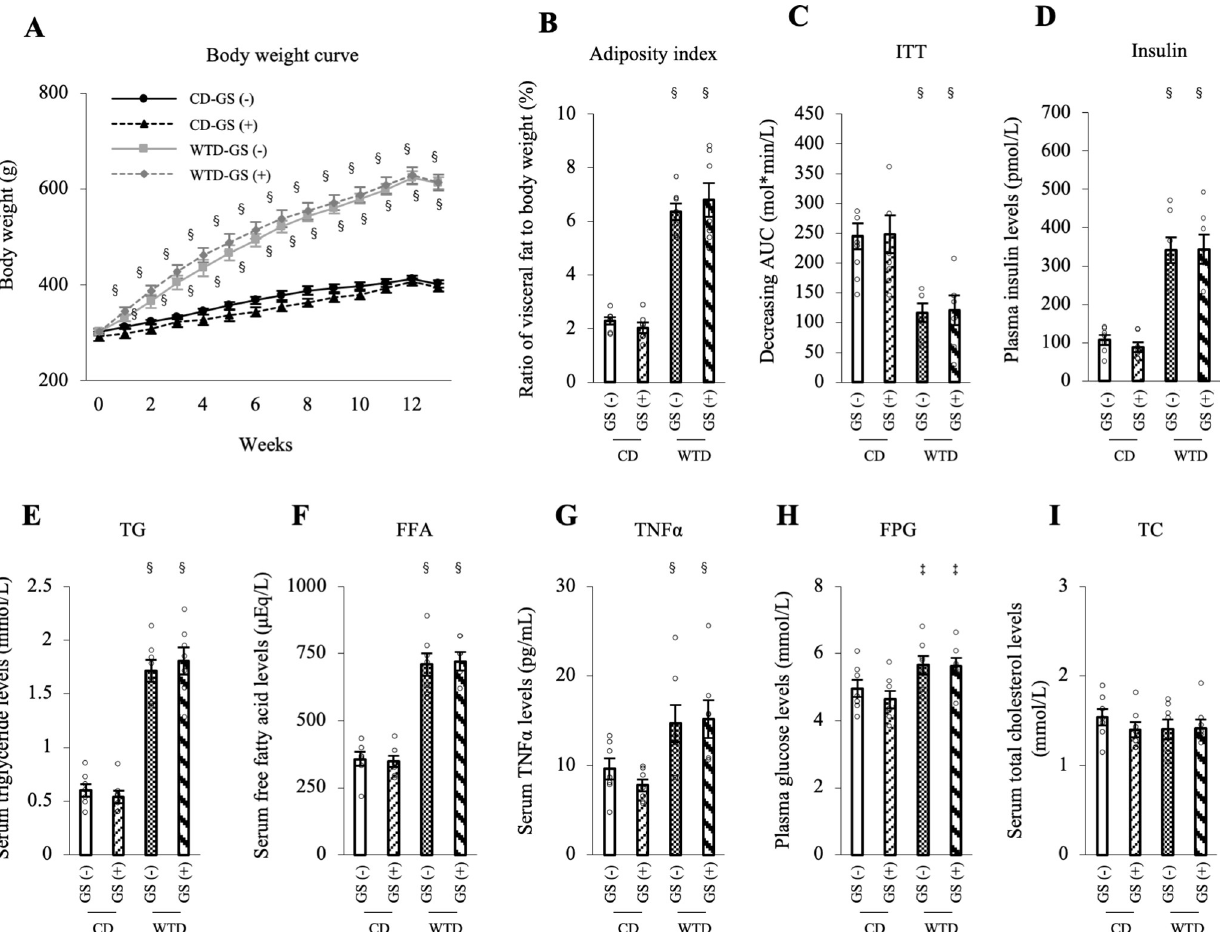
Fig 3. Endothelial dysfunction in the WTD-GS (+) group is independent of metabolic parameters. A: Body weight curve over the duration of feeding and administration. § P < 0.001 comparison between diet groups, two-way repeated-measures ANOVA. B: Adiposity index (the ratio of epididymal, retroperitoneal and mesenteric fat mass to body weight). C: ITT. Insulin resistance is presented as the decreasing glucose AUC. D-I: Plasma insulin (D), serum TG (E), FFA (F), TNF α (G), FPG (H), and serum TC (I) levels. ‡ P < 0.005 and § P < 0.001 for the comparison between diet groups, two-way ANOVA. No interaction was detected between diet and GS factors. Data are presented as the means ± SEM. N = 7 rats per group. CD, control diet; WTD, Western-type diet; GS, glucose spike.